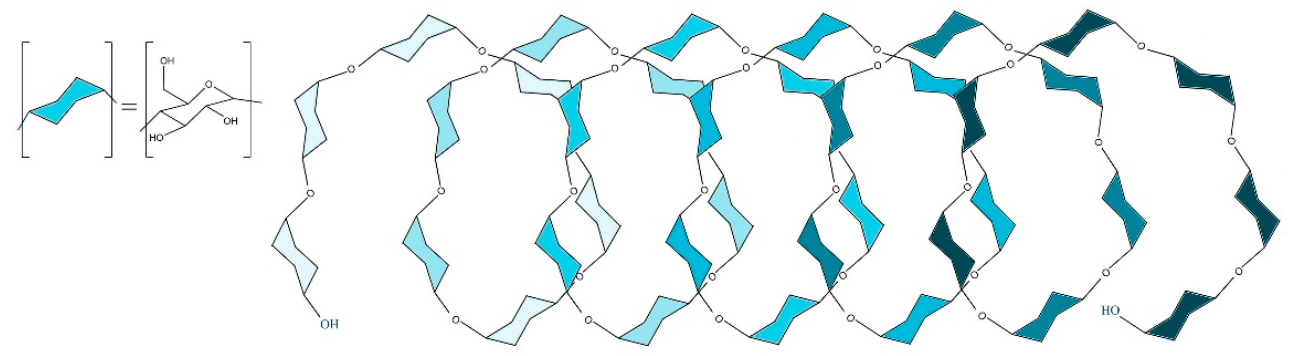
Figure 2. Helical structure of amylose Linecaps ® .